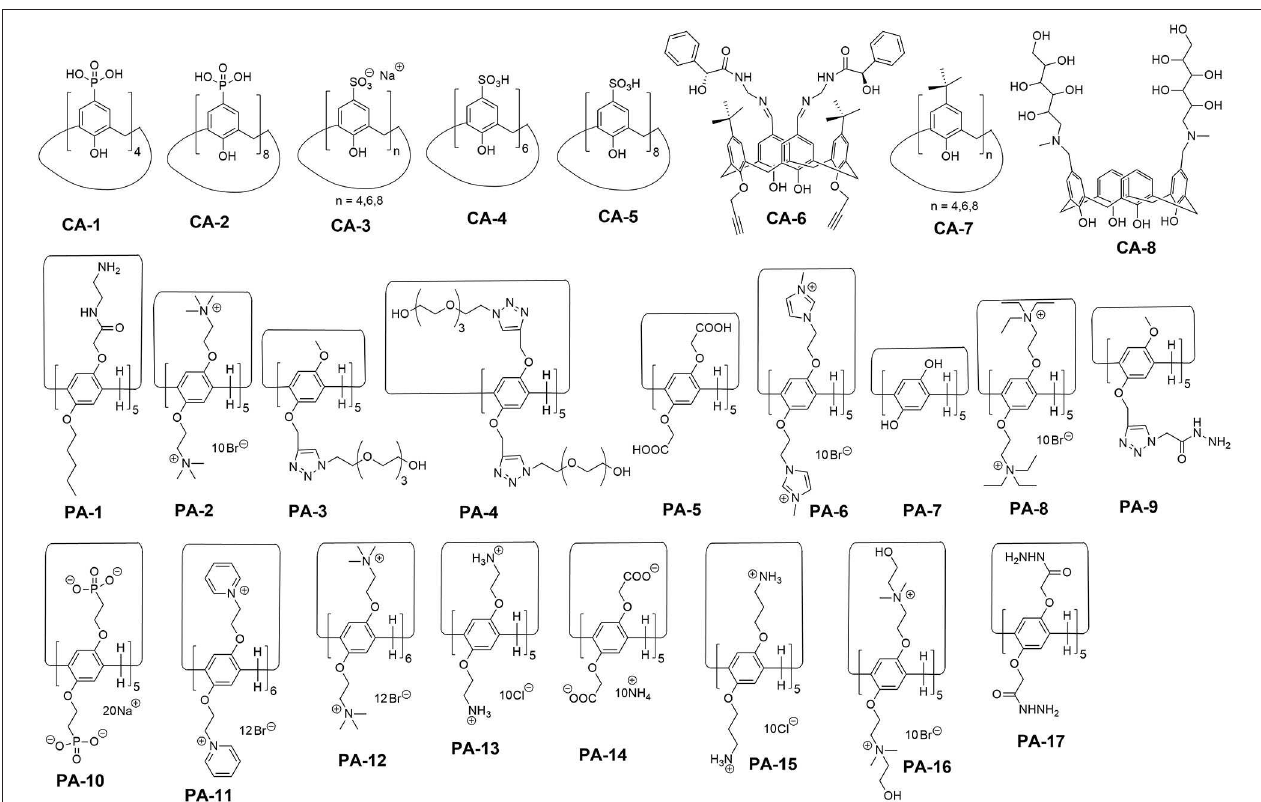
FIGURE 2 | Structures of calix[n]arenes and